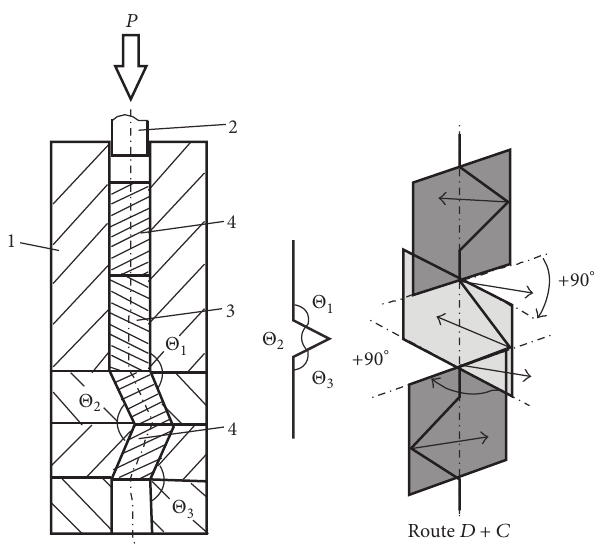
Figure 1: Scheme of ECMAE process: 1: die; 2: punch; 3: polymeric billet; 4: sacrified